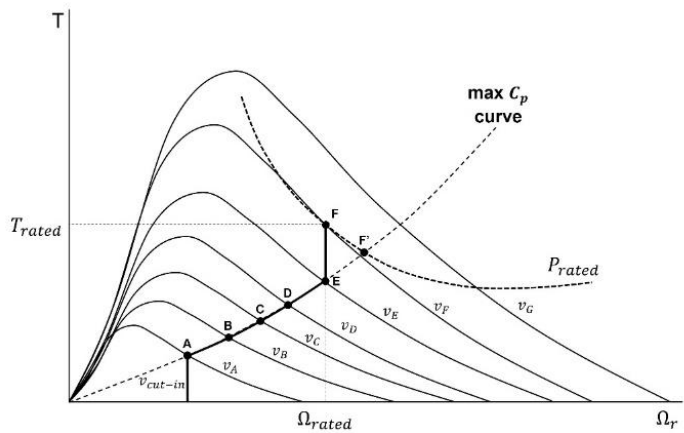
Figure 5. Pitch control wind turbine torque, rotational speed diagram.